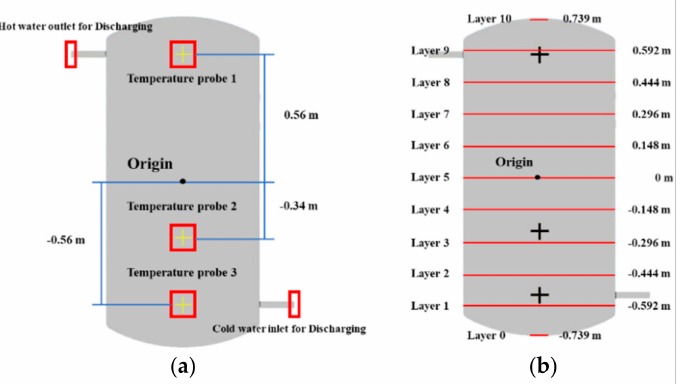
Figure 2. The temperature measuring positions in the storage tank: ( a ) the position of temperature probes; ( b ) the position of collecting planes in the numerical